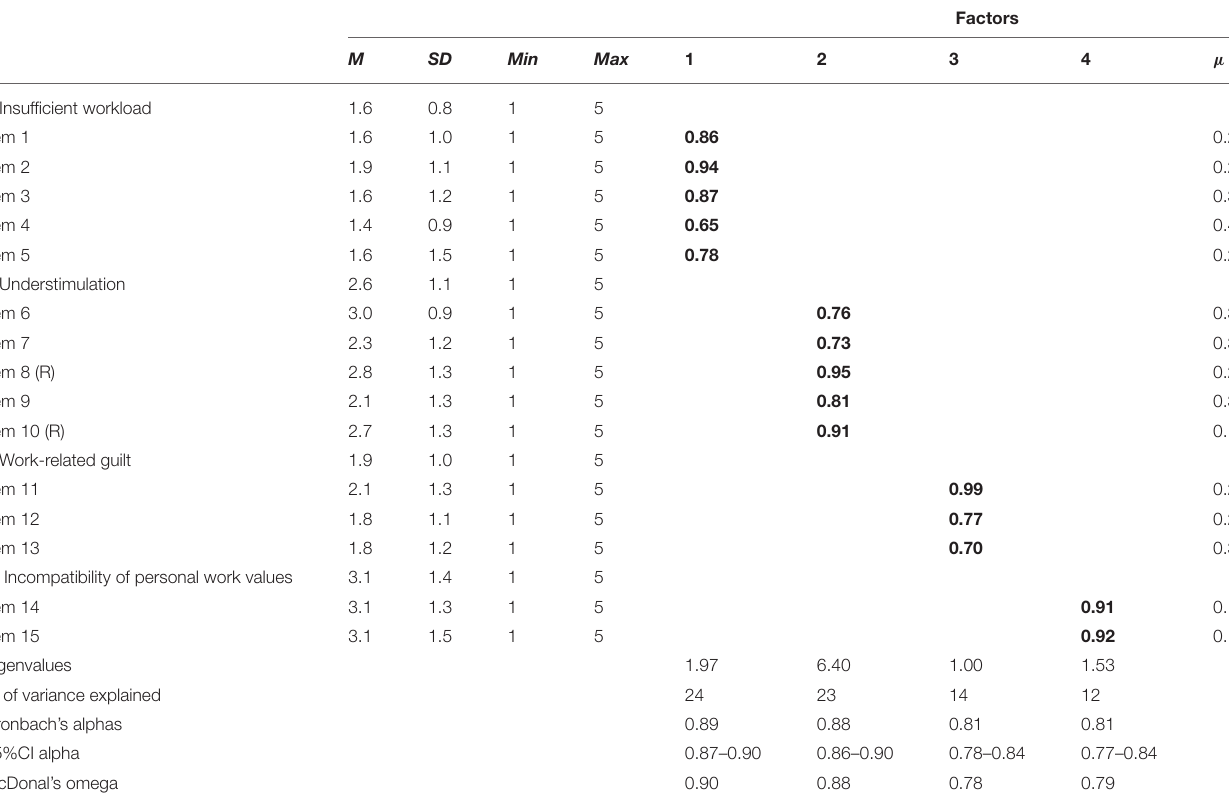
TABLE 1 | Descriptive statistics, loadings, uniqueness, internal consistency and